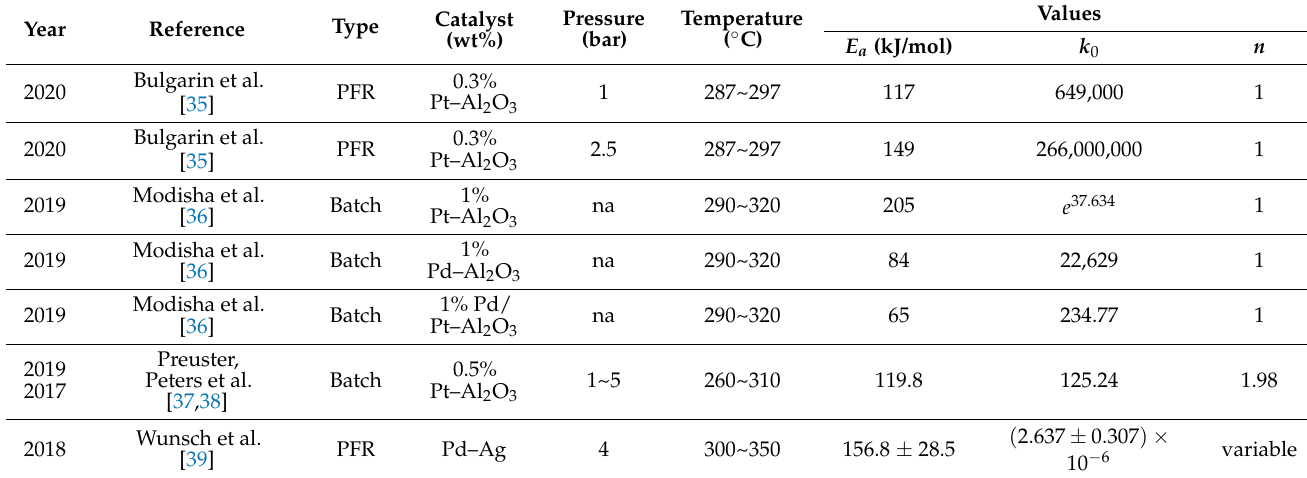
Table 4. Kinetic models for the dehydrogenation of H18-DBT proposed by various